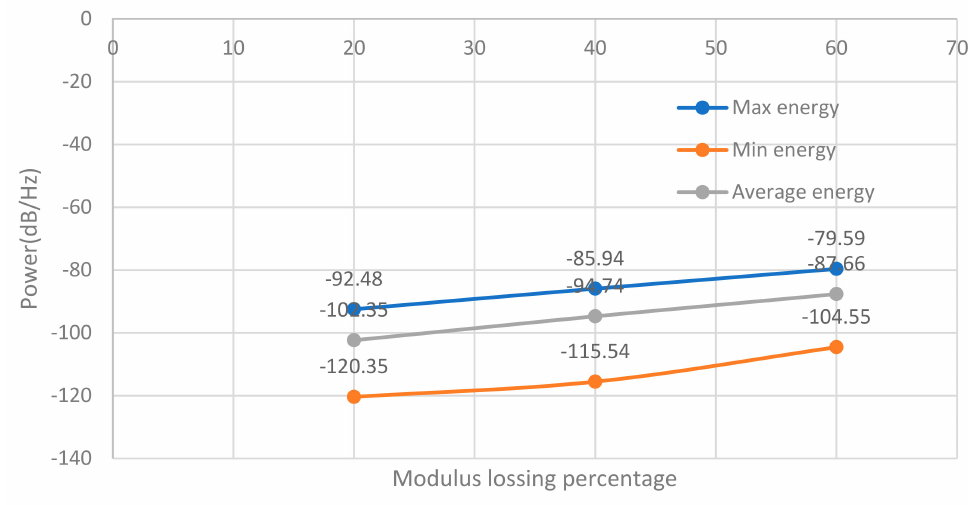
Figure 9. Comparison of STFT results of bridge accelerations with different damage levels.